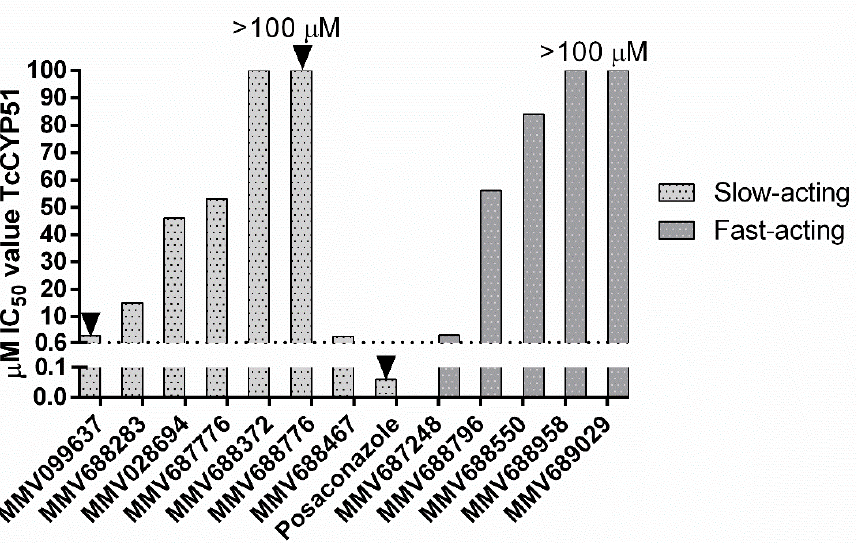
Figure 1. IC 50 values of slow and fast-acting compounds active against TcCYP51. Where IC 50 values reach 100 µ M, the IC 50 value is >100 µ M. Arrows denote compounds with a sub-efficacious E max following 48 h incubation. MMV099637 = 70% E max ; MMV688776 = 88%, Posaconazole = 73% E max . Dashed line = 10× the IC 50 value of posaconazole as a cut off for CYP51 inhibition.